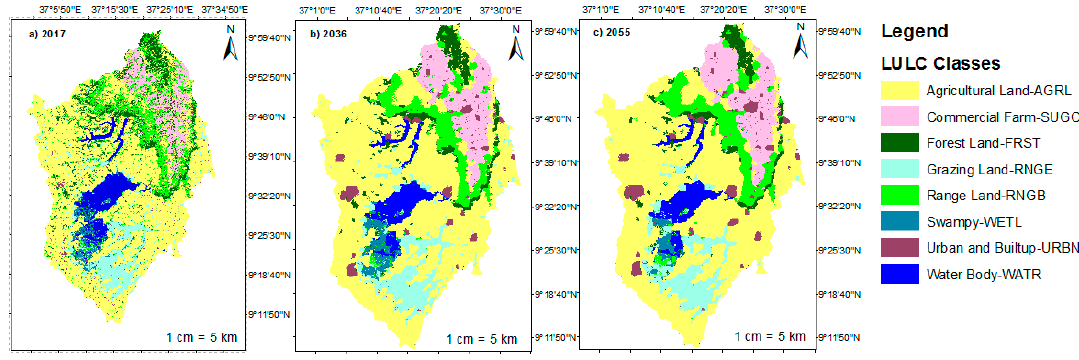
Table 2. Percentage (%) of LULC in Finchaa catchment.